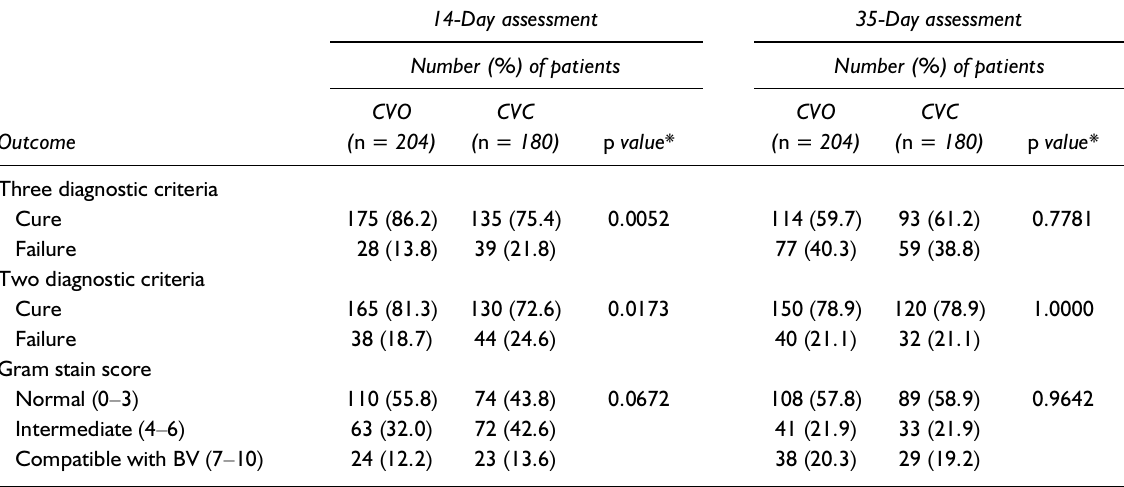
Table 2 Clinical cure rates and Gram stain results at 14- and 35-day assessments among evaluable patient population